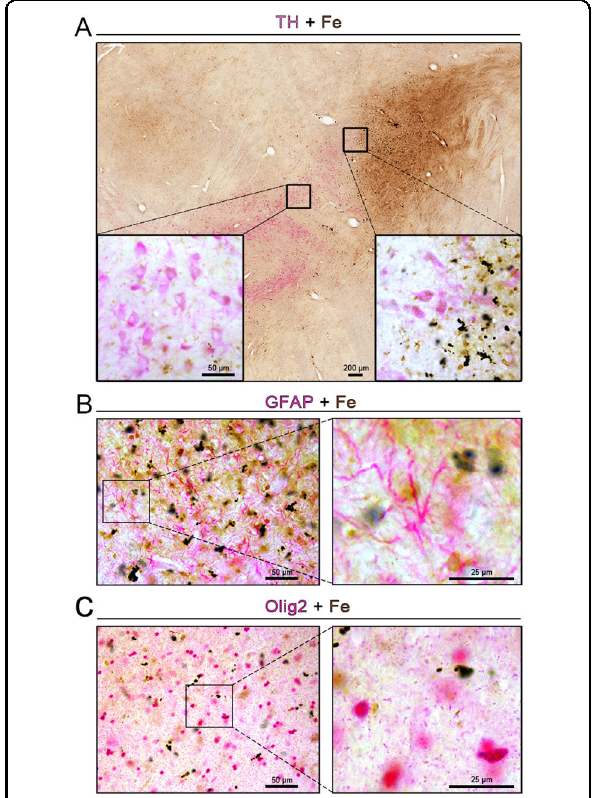
Fig. 4 Cellular localization of iron deposits in the substantia nigra. A – C Double-labeling of chemically stained iron ions (dark brown) along with immunohistochemically stained with TH ( A ), GFAP ( B ), or Olig2 ( C ) antibody (magenta) showed heavy iron deposition 17 months after treatment with α -syn PFFs. The inset images depict the enlarged small boxes in A – C . Scale bars: 200 μ m in A and 50 µm in the inset; 50 µm in B , C , and 25 µm in the enlarged